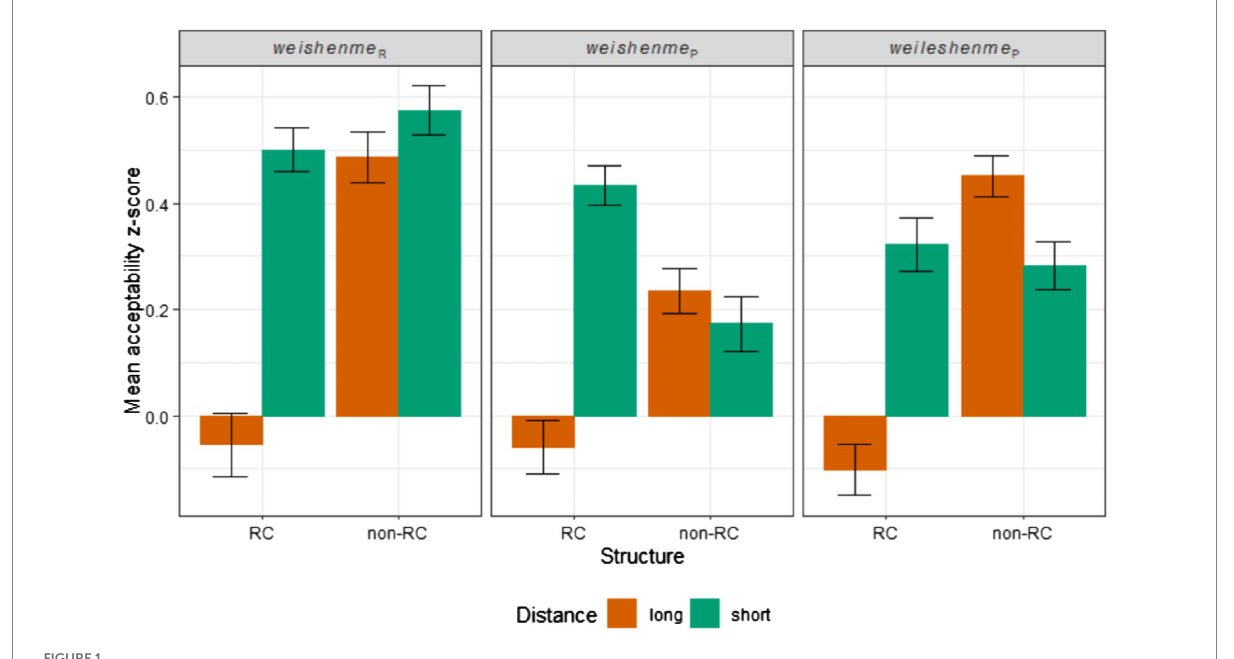
FIGURE 1 Mean acceptability Z-scores for all